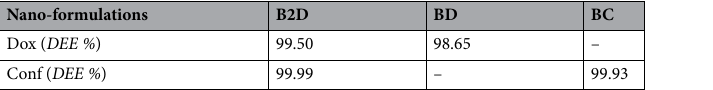
Table 2. Results of drug encapsulation efficiency (DEE %) for nano-formulations (Abbreviations: B2D: co-drug loaded βCD-g-PMA-co-PLGA micelles, BD: Dox loaded βCD-g-PMA-co-PLGA micelles, BC: Conf loaded βCD-g-PMA-co-PLGA